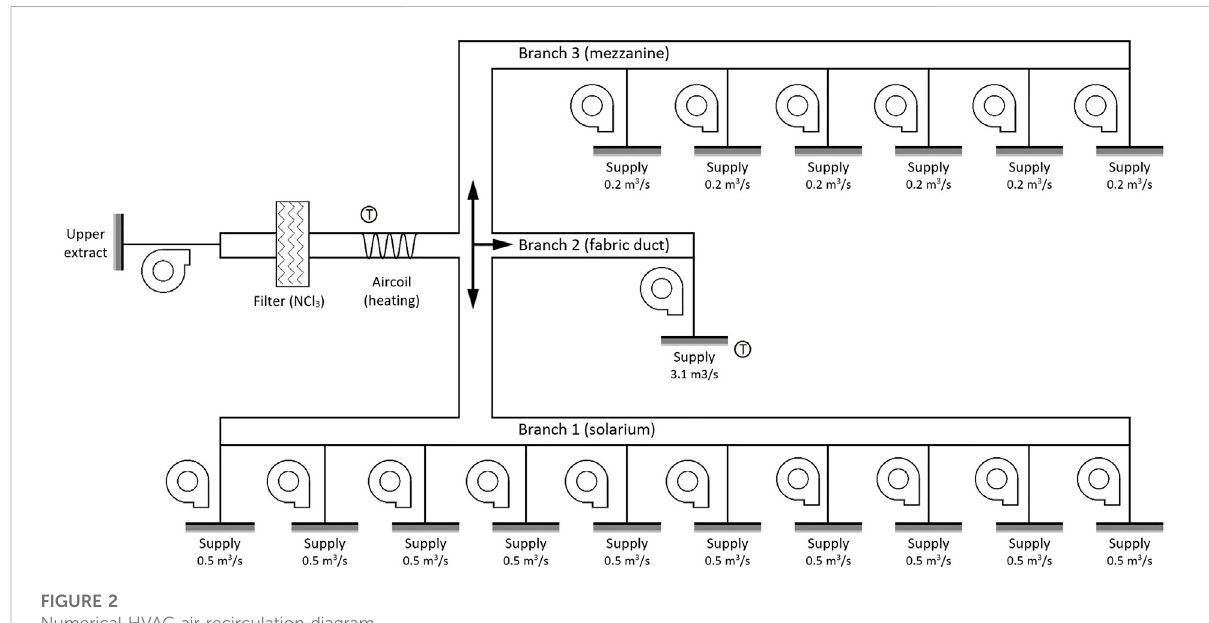
FIGURE 2 Numerical HVAC air recirculation